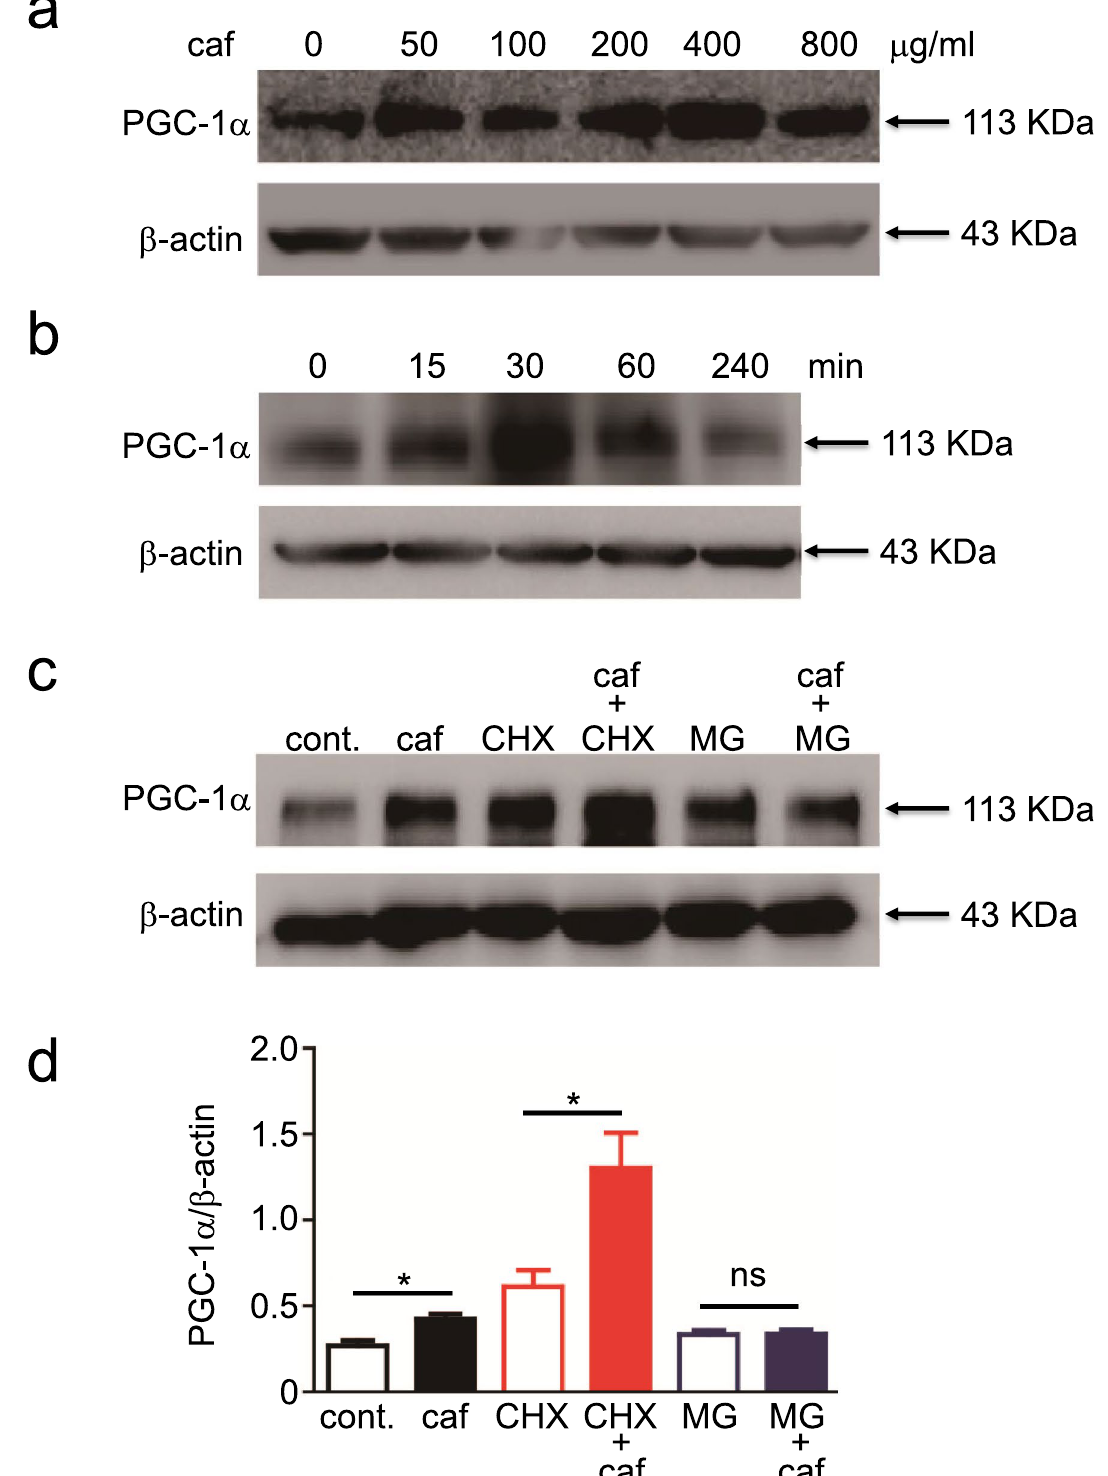
Figure 6. Caffeine enhanced PGC-1α by inhibiting its proteasomal degradation. ( a , b ) C2C12 myotubes were incubated with various doses ( a ) or 400 μg/mL ( b ) of caffeine for various durations ( b ) or 24 h ( a ). ( c , d ) The myotubes were preincubated with cycloheximide (CHX) or MG132 (MG) for 1 h, followed by incubation with 400 μg/mL caffeine (caf) for 24 h. PGC-1α and β-actin levels were analysed by western blotting ( a – c ). PGC-1α images ( c ) were normalised to the transcript level of the individual β-actin ( d ). Data are shown as mean ± SEM of the triplicate experiments. Similar results were obtained in three independent experiments. * p <